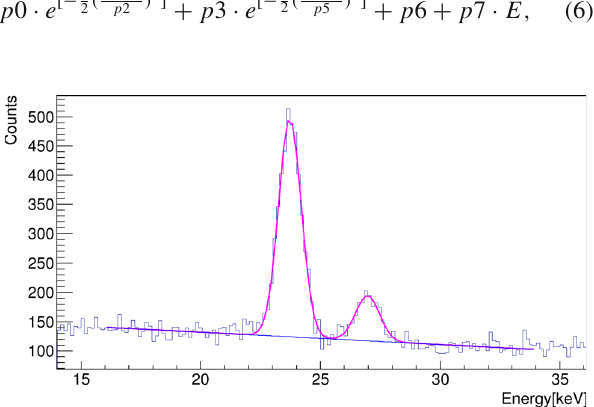
Fig. 18 The fitted energy peaks at 24 keV and ∼ 27.5 keV from flu- orescent emission of X-ray with applied voltage at 400 V when the source was placed at the bottom of the cryostat